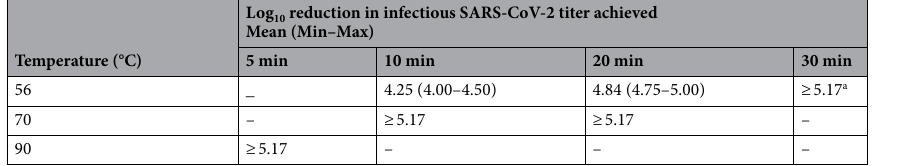
Table 7. Effects of heat on SARS-CoV-2 inactivation. a The value of ≥ 5.17 means that no live virus is observed after the treatment, while the smaller values indicate that a different amount of virus survives after the